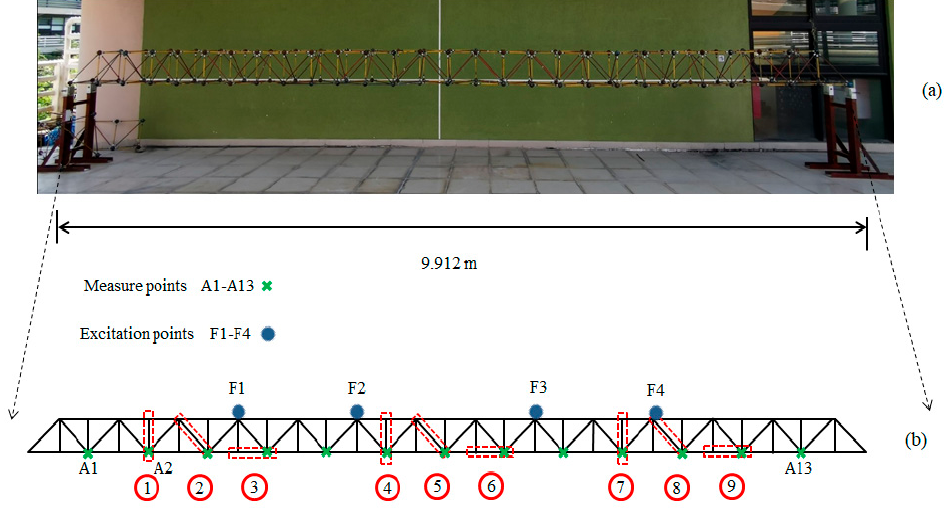
Figure 1. Steel frame with 355 rods. (a) Laboratory steel frame, (b) Damage parts.